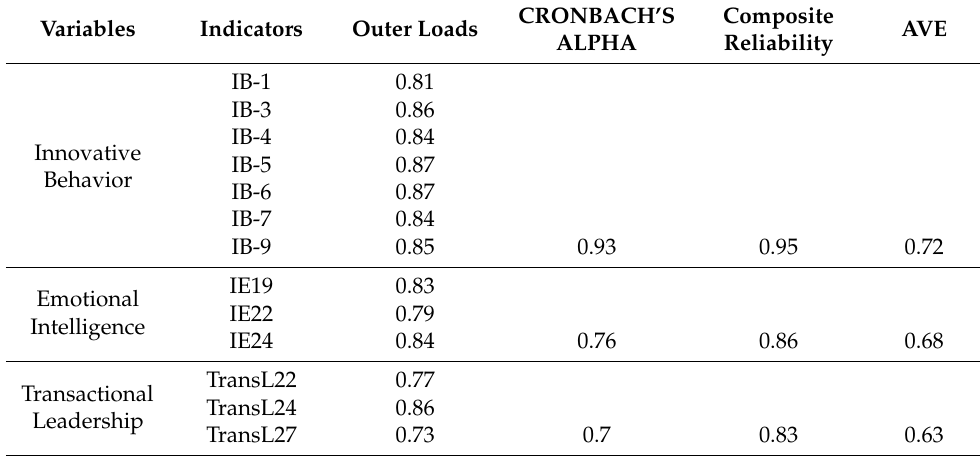
Table 1. Assessment of the measurement model through reliability and validity. Variables